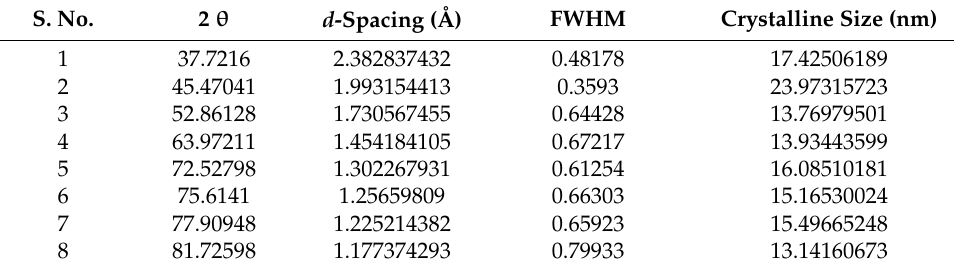
Table 1. The X-ray diffraction peak data of Ag-Cu-Co trimetallic nanoparticles. S.